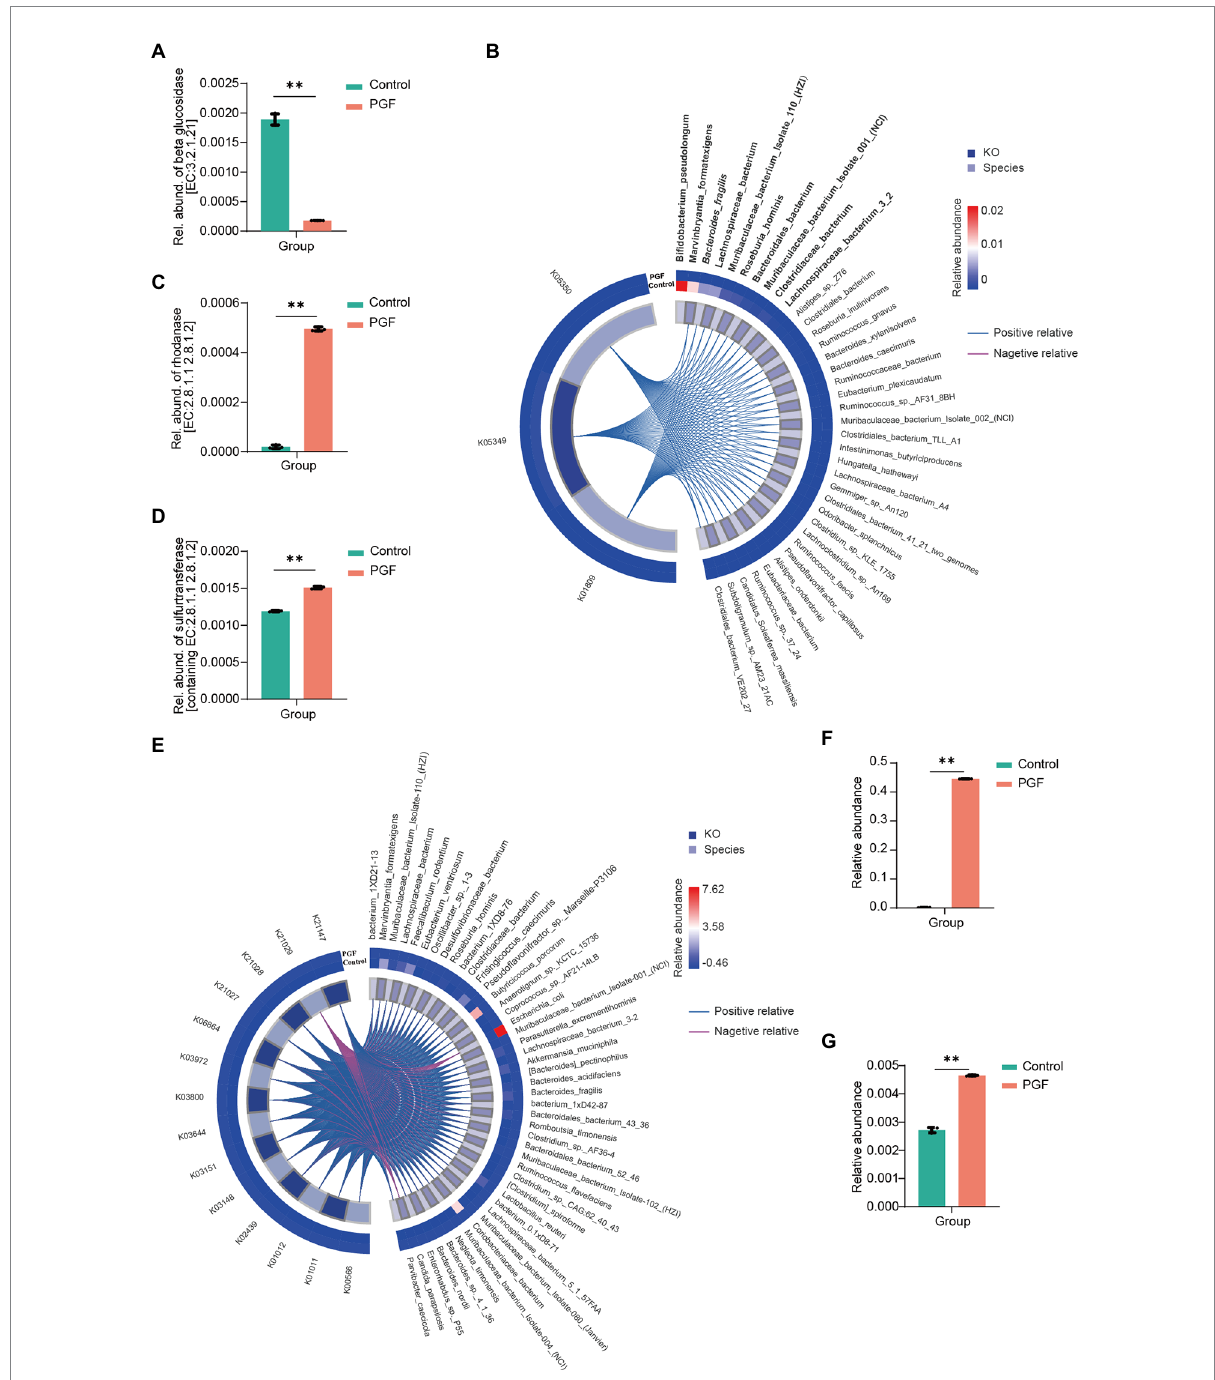
FIGURE 9 Identified species and annotated gene based on the metagenomic gene sequencing (n = 3). (A) Relative abundance of β -glucosidase (EC:3.2.1.21); (B) Correlation between β -glucosidase-related KEGG Orthologs (KO) and bacterial species (Top10 species were shown in bold, and italics were reported in previous studies), based on the determined 7 orders relative to cyanogenesis of amygdalin by Pearson correlation analysis; (C) Relative abundance of genes encoding putative rhodanese (EC:2.8.1.1 2.8.1.2), p < 0.01; (D) Relative abundance of genes encoding all the sulfurtransferases (including EC:2.8.1.1 2.8.1.2), p < 0.01; (E) Correlation between sulfurtransferase-related KO and the bacterial species identified by metagenomic sequencing; (F) Relative abundance of Escherichia coli ; (G) Relative abundance of Nitrogen metabolism pathway via KEGG